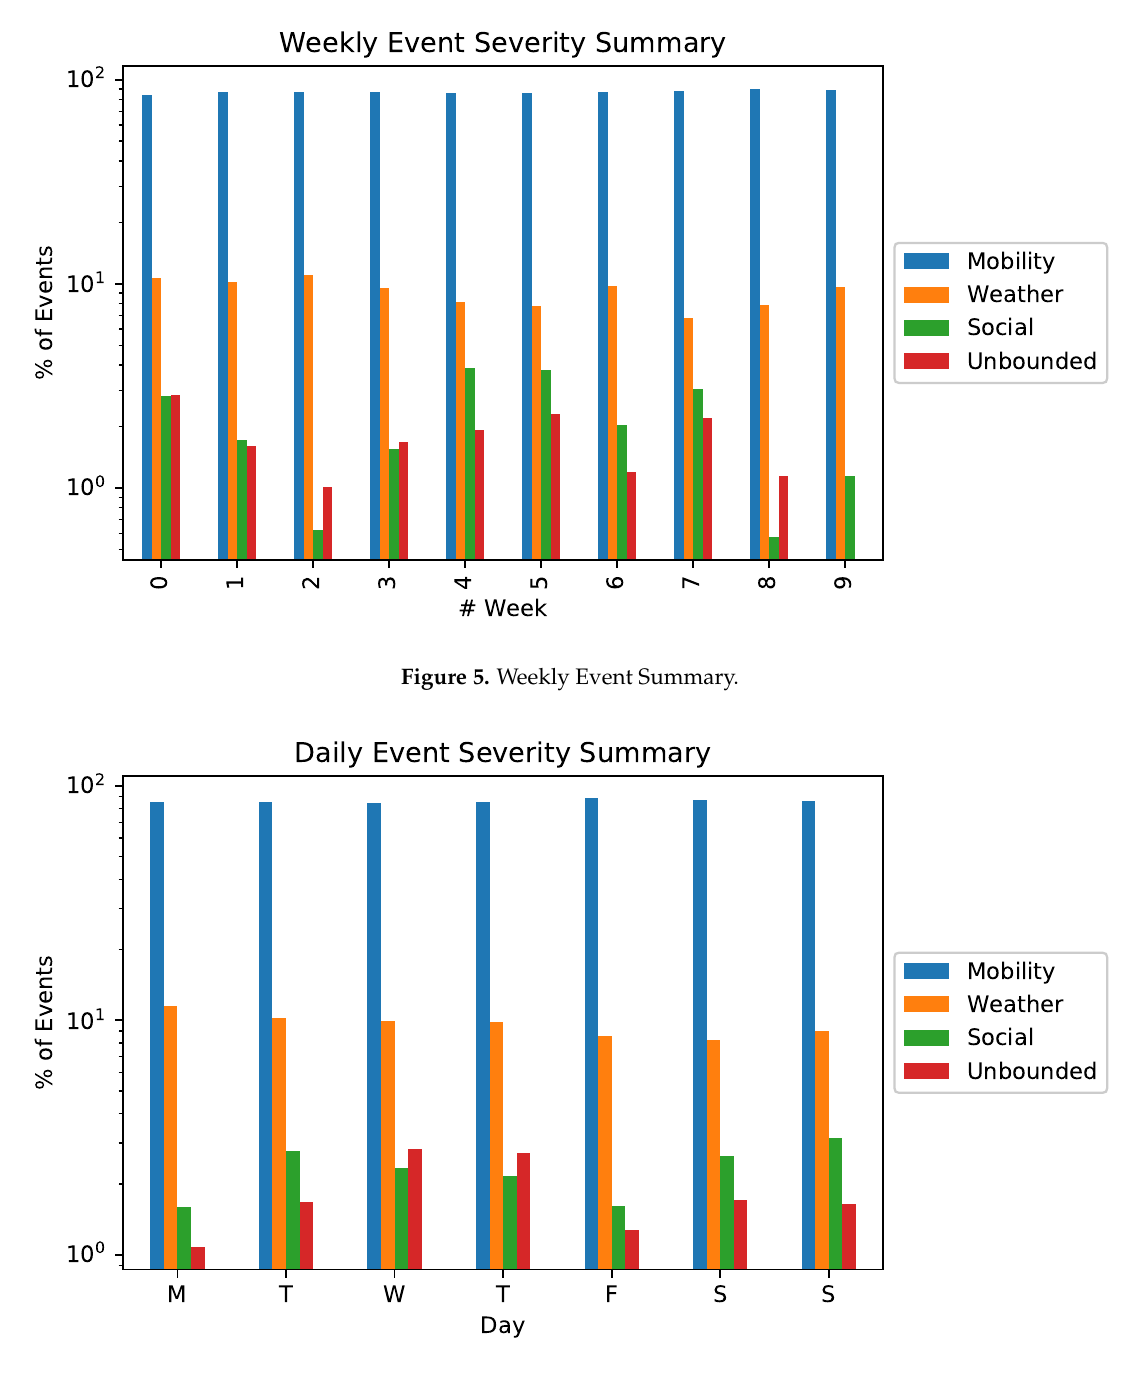
Figure 6. Daily Event